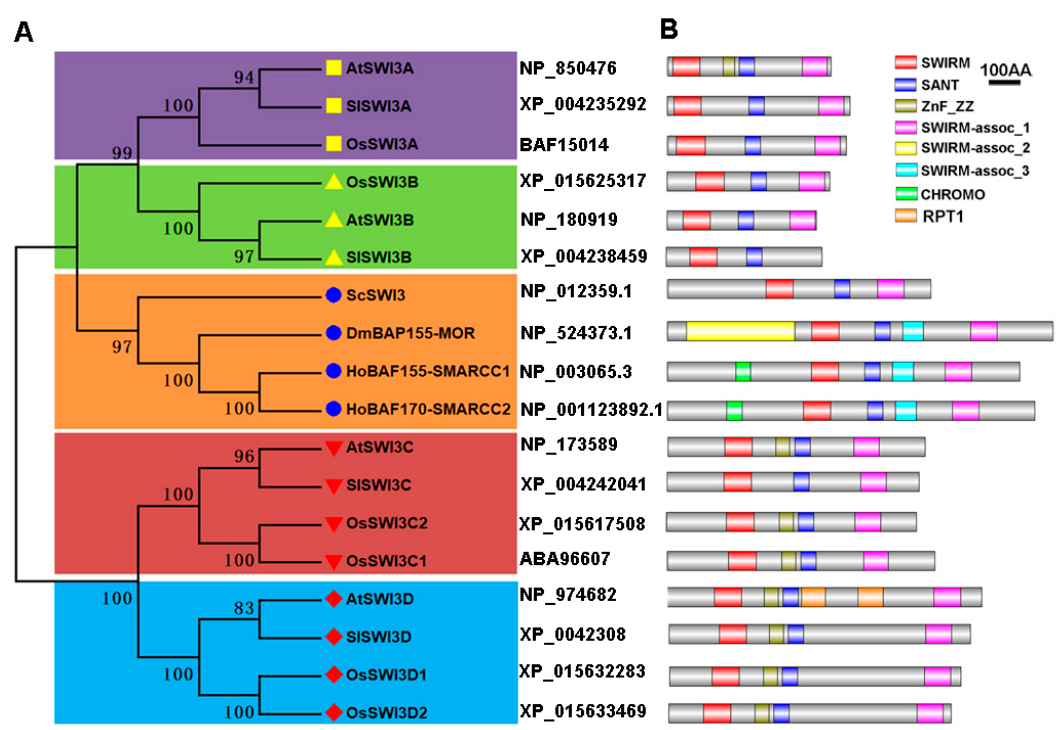
Figure 1. Phylogenetic tree and domain architecture of SlSWI3s in tomato. ( A ) Phylogenetic tree of Swi3-like proteins in plants and animal. Neighbor-joining (NJ) phylogenetic tree for SWI3s in S. cerevisiae (Sc), D. melanogaster (Dm), H. sapiens (Ho), A. thaliana (At), and S. lycopersicum (Sl). The groups of homologous genes identified, bootstrap values and accession numbers are shown. The reliability of branching was assessed by the bootstrap resampling method using 1000 bootstrap replicates. ( B ) Domain architecture of the Swi3-like proteins was drawn by DOG2.0. according to analysis by SMART and PFAM searches. The location of domains is shown by di ff erent color as indicated. The scale represents the length of the protein and all proteins are displayed in proportion. The proteins belonging to each family are grouped